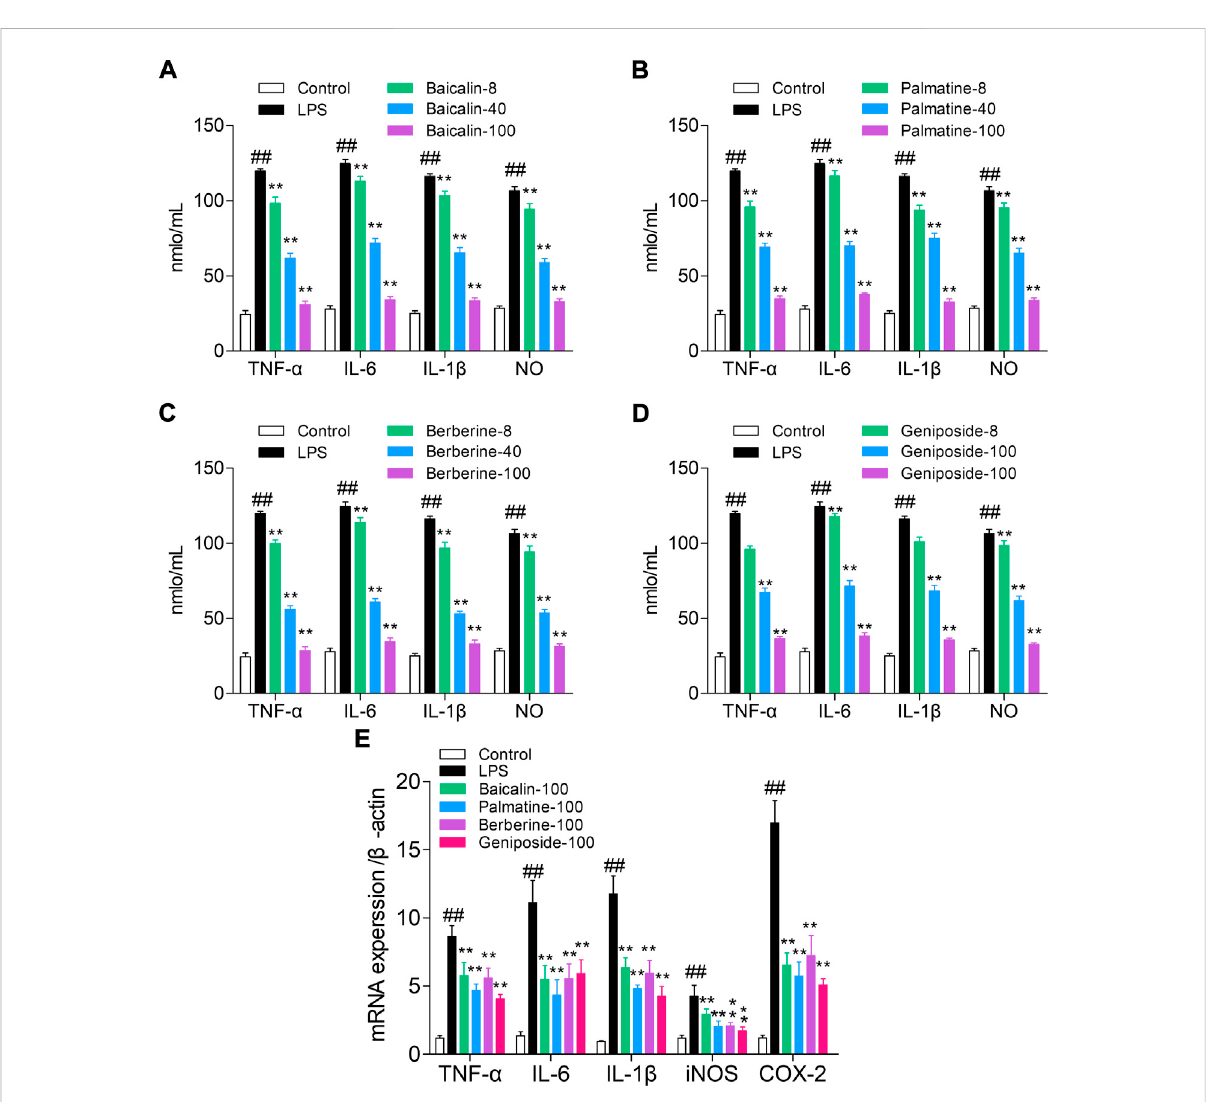
FIGURE 2 Study on thepathway of active components with high af fi nity, and the quantitative units inthe fi gures (forexample, 8, 40, and 100)were μ g/ml. (A) Effect of baicalin on cytokines(NO, TNF- α , IL-6, and IL-1 β )in RAW 264.7 cells; (B) Effect of palmatine on cytokines(NO, TNF- α , IL-6, and IL-1 β )in RAW264.7cells; (C) Effectofberberineoncytokines(NO,TNF- α ,IL-6,andIL-1 β )inRAW264.7cells; (D) Effectofgeniposideoncytokines(NO,TNF- α , IL-6, and IL-1 β ) in RAW 264.7 cells; (E) mRNA expression of iNOS, IL-1 β , IL-6, TNF- α , and COX-2 in RAW 264.7 cells treated with baicalin, palmatine, berberine, or